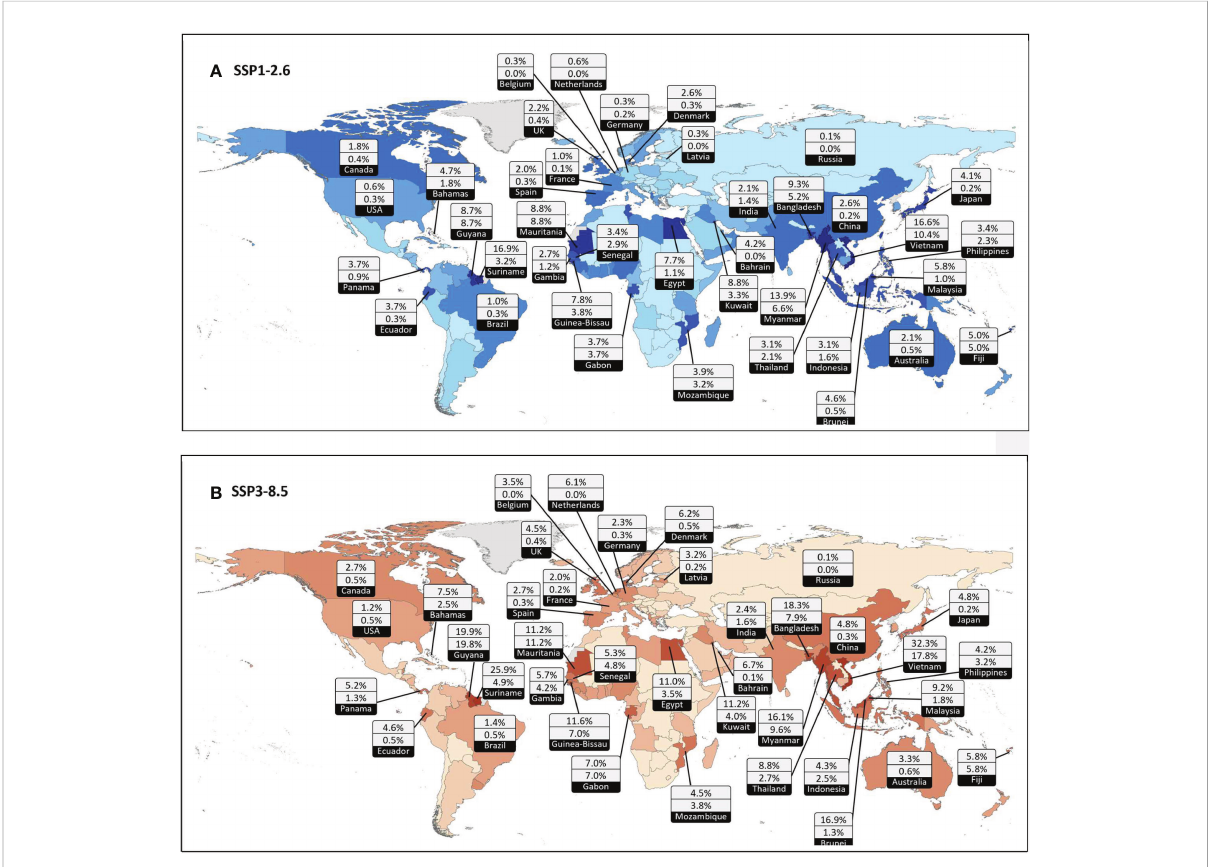
FIGURE 5 Infographic showing national percentage EAD of GDP for (A) SSP1-2.6 and (B) SSP3-8.5. For each “ data bubble ” the top fi gure is the no additional adaptation scenario and the bottom number is adaptation matching ESL change scenario. Nation colour code (from lighter to darker) is proportional to percentage EAD for no additional adaptation scenario (top number). Map national boundaries from NASA Socioeconomic Data and Applications Center (SEDAC)